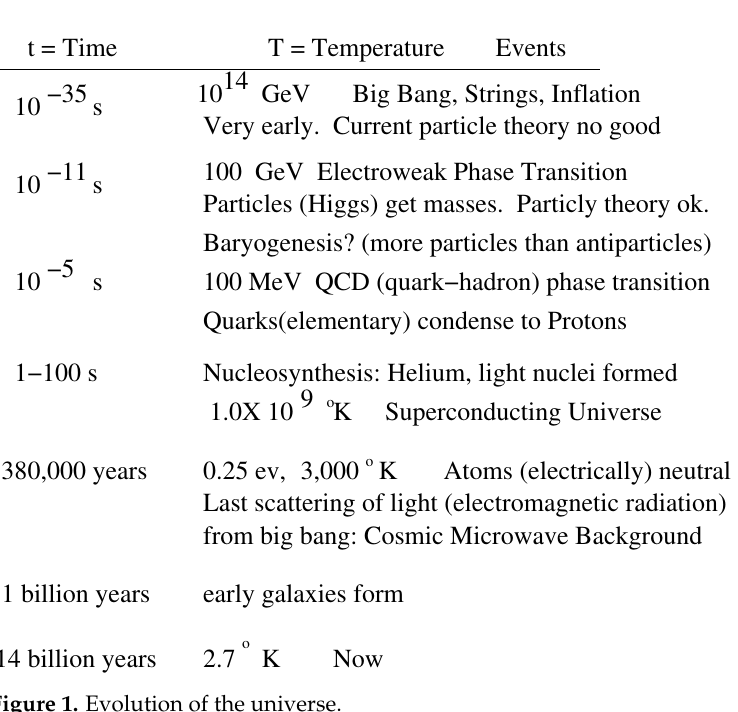
Figure 1. Evolution of the